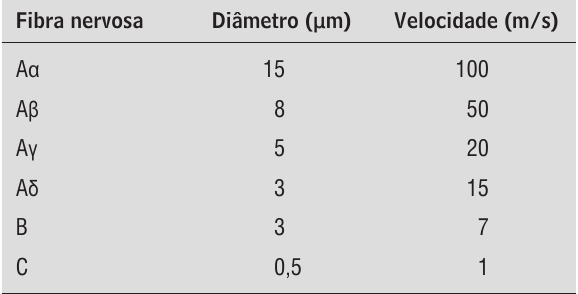
Tabela 1 - Classificação da fibra nervosa em função